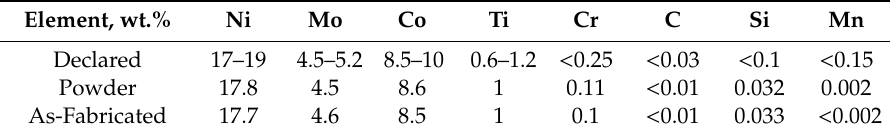
Table 1. Comparison of the chemical composition of declared, real, and as-fabricated 18Ni-300. Element, wt.% Ni Mo Co Ti Cr C Si Mn Declared 17–19 4.5–5.2 8.5–10 0.6–1.2 < 0.25 < 0.03 < 0.1 < 0.15 Powder 17.8 4.5